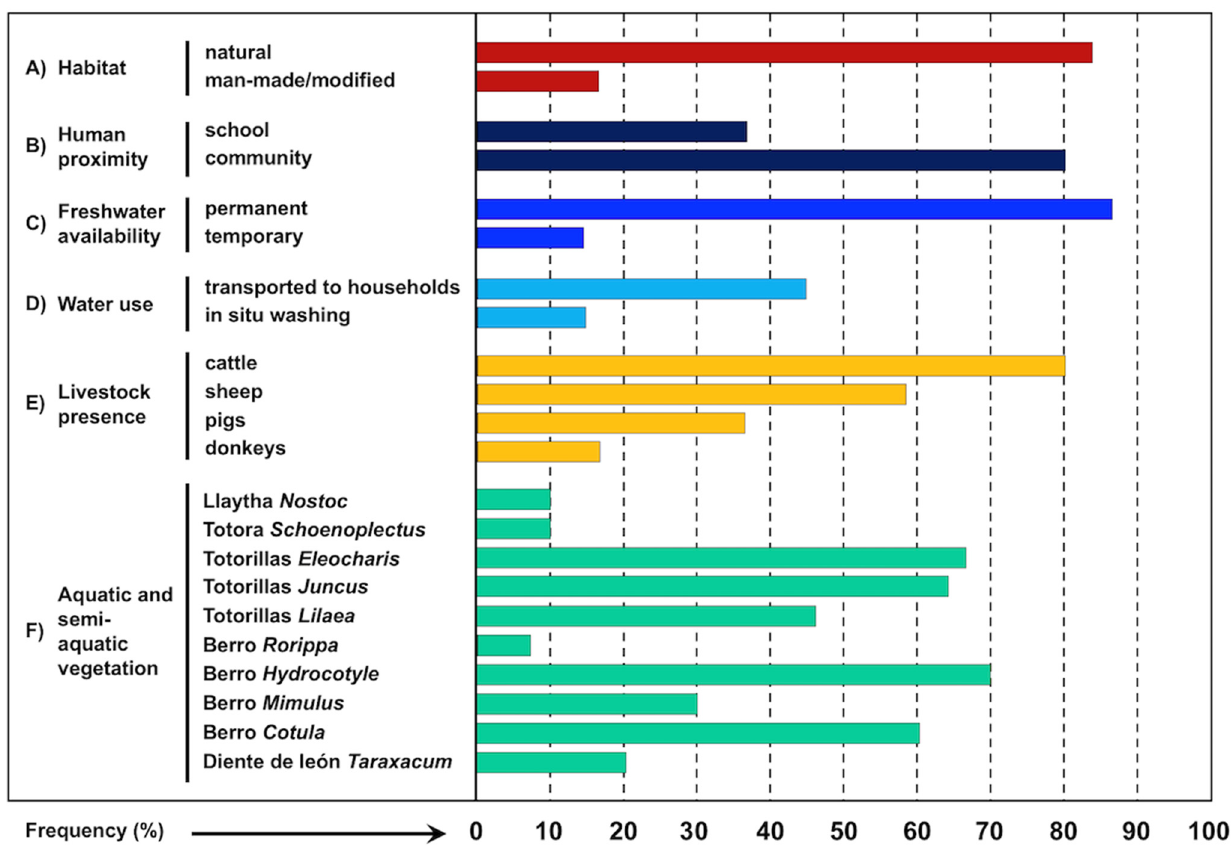
Figure 4. Results (%) of the quantitative analyses of the characteristics of the 67 freshwater collections inhabited by Galba truncatula snail vectors surveyed throughout the human fascioliasis hyperendemic area in the Northern Bolivian Altiplano, including frequency percentages of presence of main infection-linked vegetables in a total of 30 of these fascioliasis transmission foci which were analysed both at the end of the raining season and at the end of the dry season of different years.